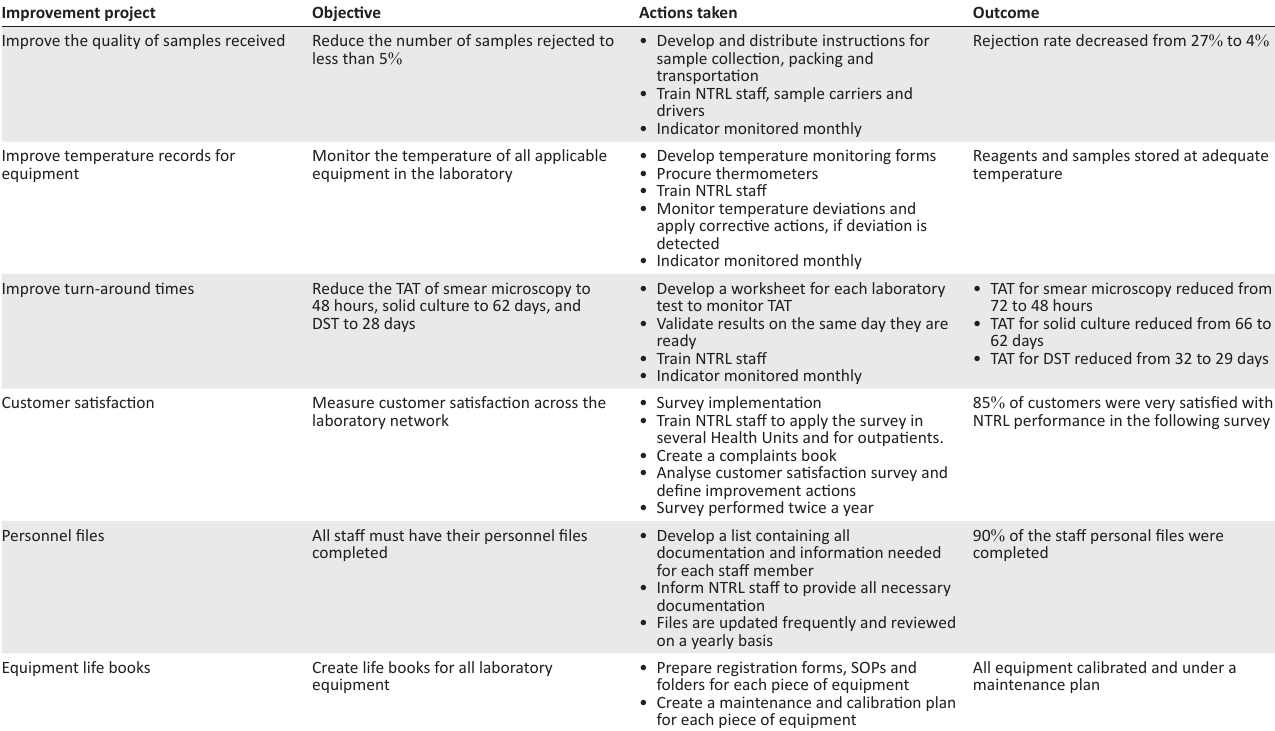
FIGURE 2: Timeline of events in the pathway to ISO 15189 accreditation, Mozambique, 2011–2015. TABLE 1: National Tuberculosis Reference Laboratory improvement projects during first round of Strengthening Laboratory Management Toward Accreditation, 2011–2013,